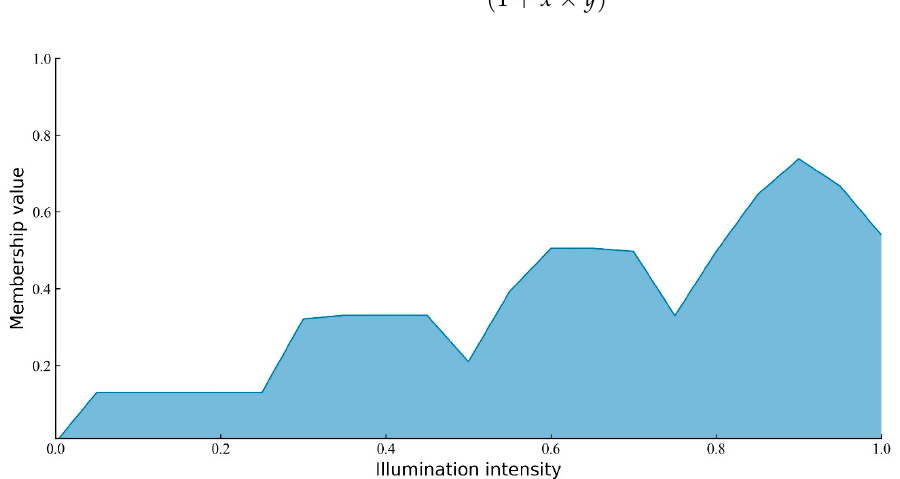
Figure 10. Defuzzification of the aggregated membership functions. FCM is an inference network that represents knowledge and reasoning using cyclic digraphs, and it can implement tasks such as modeling, analysis, decision making, and forecast by combining fuzzy logic with networks. The dynamics of the specified FCM are